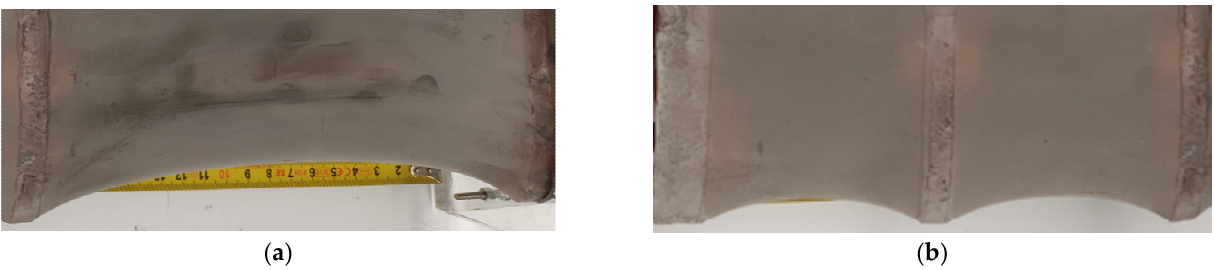
Figure 22. Poisson’s contraction in latex skin at 25% span extension: ( a ) Without riblet. ( b ) With riblet.